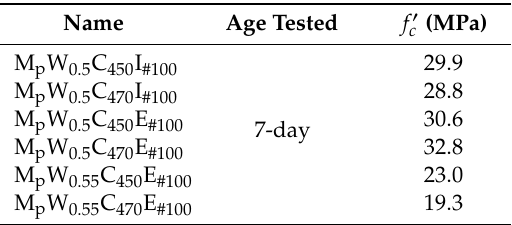
Table 6. Compressive strength of primary tests.